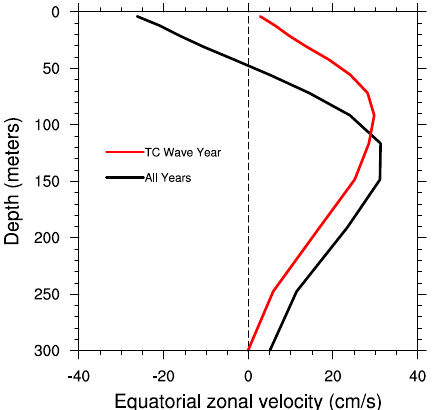
Fig. 5. Vertical profile of the modeled zonal current velocity in the equatorial Pacific between − 5 and +5 ◦ N. The black curve denotes the annual average over the 7yr forcing cycle (all years). The red curve represents the annual average during the model year with 1997 atmospheric forcing conditions (TC wave year), reflecting anomalously small vertical current shear in the background state compared to the